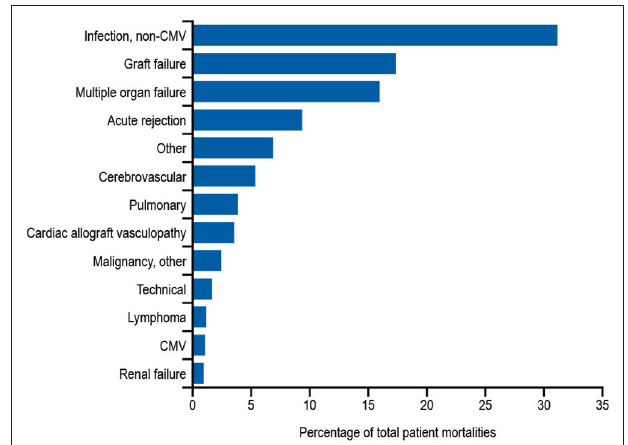
FIGURE 3 | Relative incidence of leading causes of death (31 days to 1 year) in adults receiving heart transplants Jan 1994–June 2016. Developed using data from The International Society for Heart & Lung Transplantation, (2017) ( 163); CMV, cytomegalovirus.